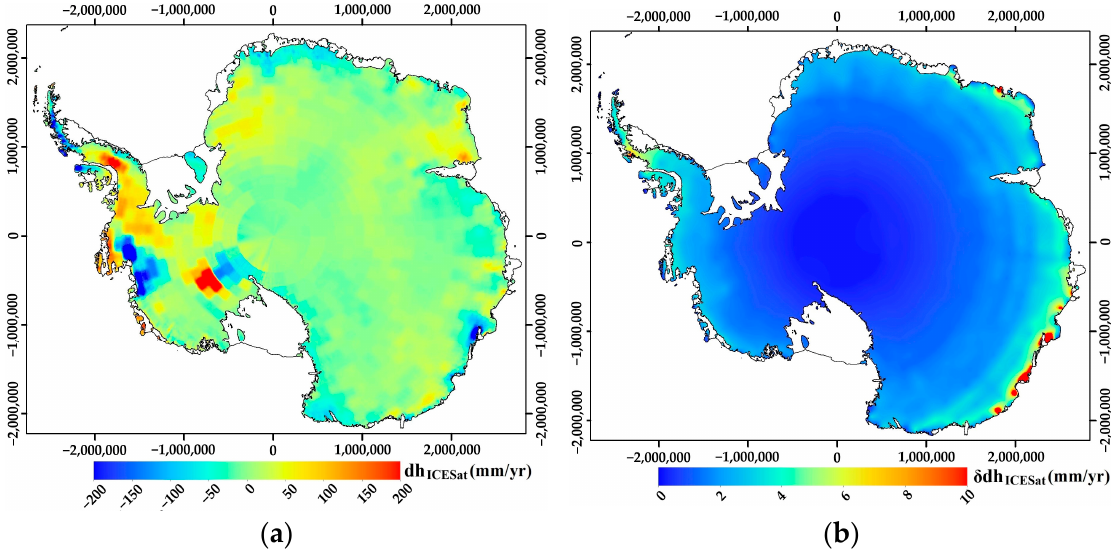
Figure 4. ( a ) Linear surface height variations trend derived from ICESat (including ICB correction) during February 2003–October 2009 (truncated at 200 mm/y). ( b ) Associated uncertainties.